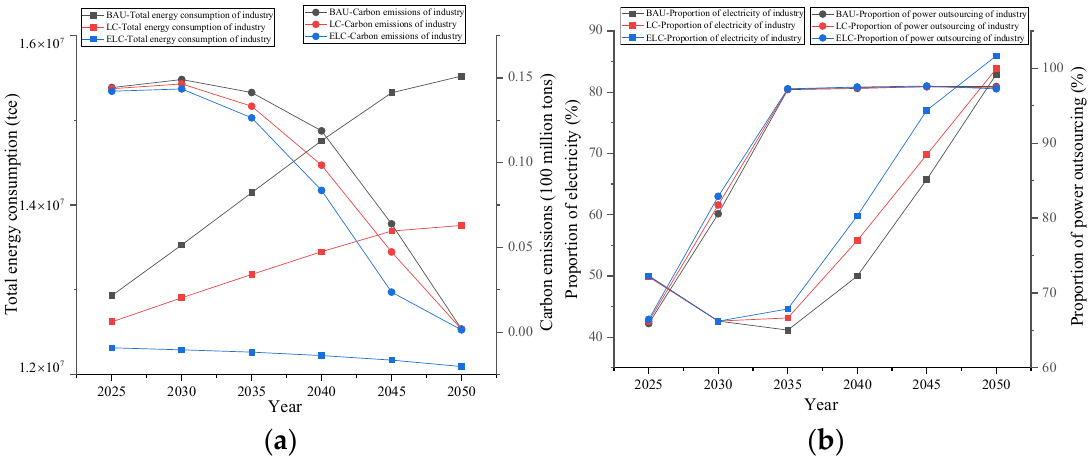
Figure 7. Analysis of the industrial sector: ( a ) total energy consumption and carbon emissions in the industrial sector; ( b ) proportion of power and external electricity in the industrial sector.